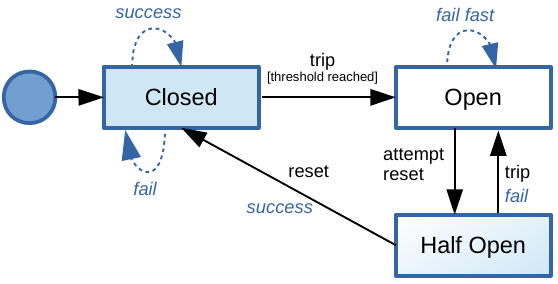
Figure 3. State transitions of a basic circuit